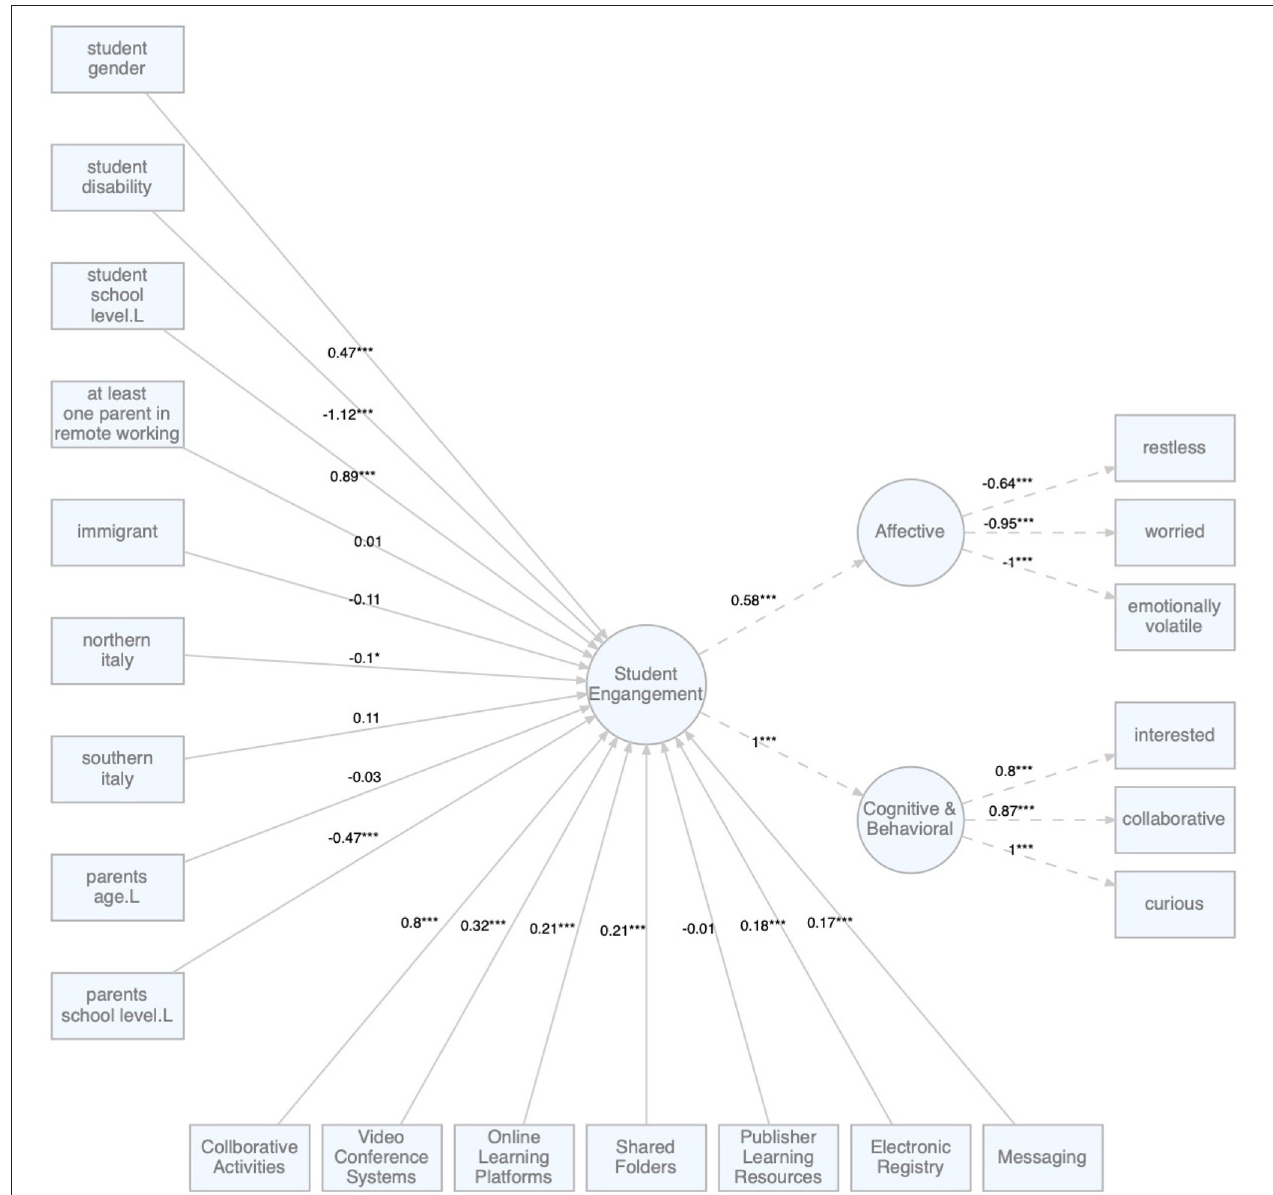
FIGURE 2 | Model A: Effects of student and family characteristics on students’ engagement. * p < 0.05; *** p <